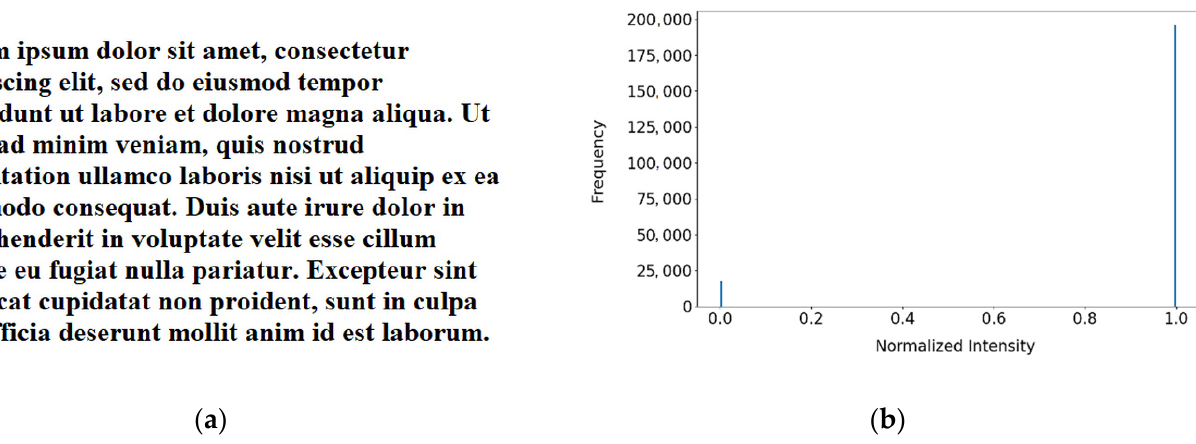
Figure 1. A sample ideal text image alongside its corresponding histogram: ( a ) ideal text image; ( b ) intensity histogram. The set of synthetically degraded images was tested for OCR accuracy using the standard Characters Correct percentage as an accuracy measure. From the synthetic image tests, it is possible to ascertain which degradations have the most significant effect on OCR accuracy. These results were used in the development of the Q-metric and the Page Extractor, which is used to extract and enhance the text in the